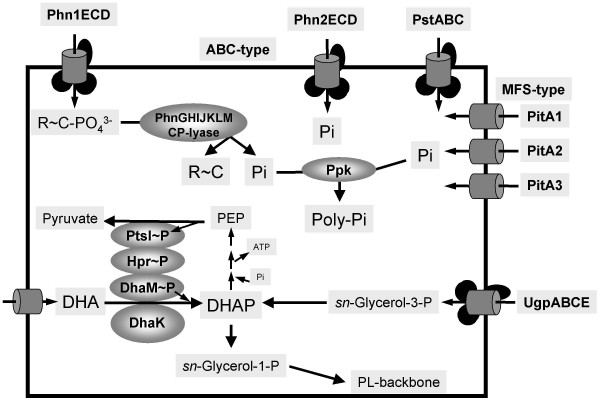
Phosphate metabolism in H. walsbyi. Scheme revealing the proteins involved in phosphate metabolism. The transporters PitA1-3, Phn2ECD, PstABC and phosphate storage enzyme polyphosphate kinase (Ppk) are common in several haloarchaea. Unique to H. walsbyi are the bacterial-type proteins involved in phosphonate metabolism, an ABC-type phosphonate uptake system plus phosphonate lyase, and the PTS dependent dihydroxyacetone kinase (DHAK). DHA, dihydroxyacetone; DHAP, dihydroxyacetone phosphate; Pi, phosphate ion; PEP, phospho enolpyruvate; PL, phospholipid.